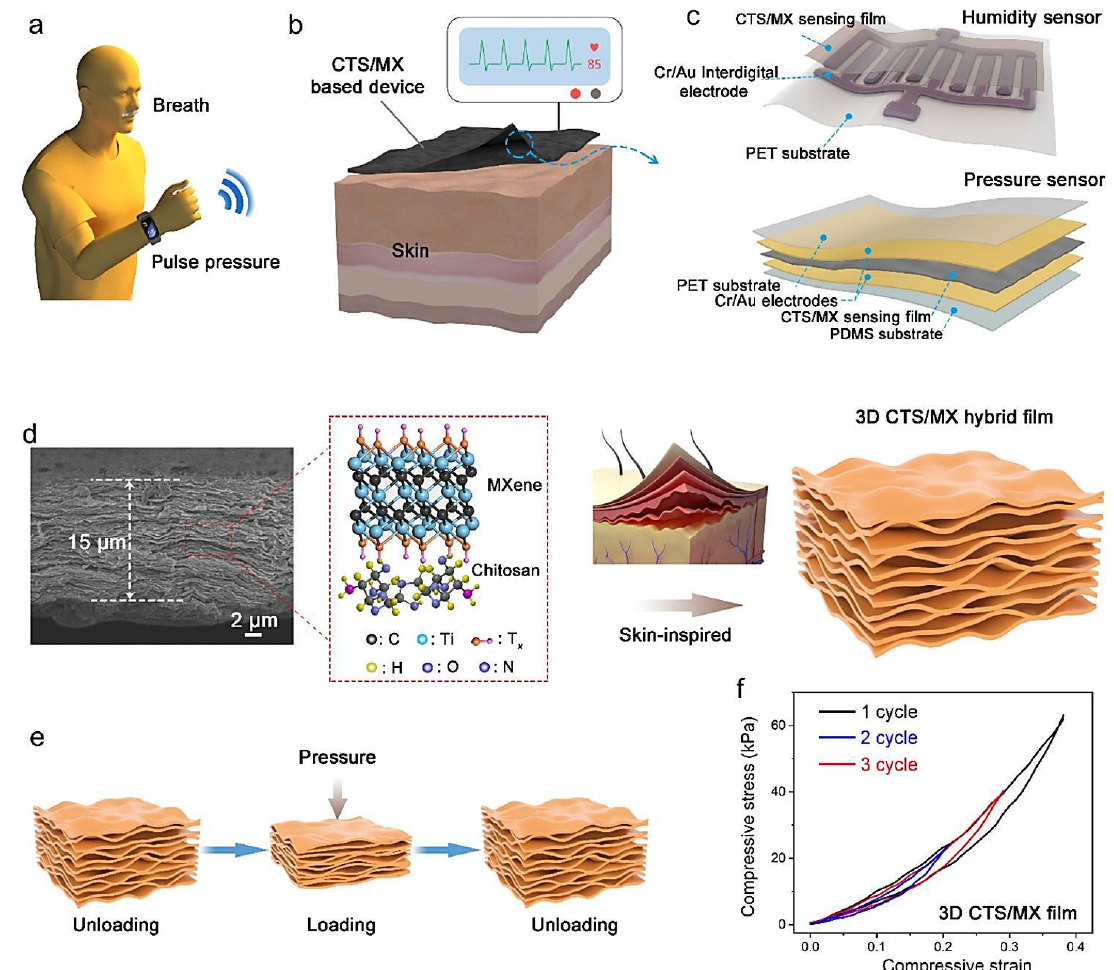
Figure 1. ( a – d ) The preparative process of biocompatible chitosan (CTS)/MXene (MX) hybrid film and the design of flexible bimodal humidity and pressure sensor for human health detection purposes. ( e ) The sensing mechanism of the designed sensor for the detection of pressure. ( f ) Compressive stress-strain curves of the prepared hybrid film under various strain values. Adapted from Ref [59] with permission. Copyright 2021 American Chemical Society.